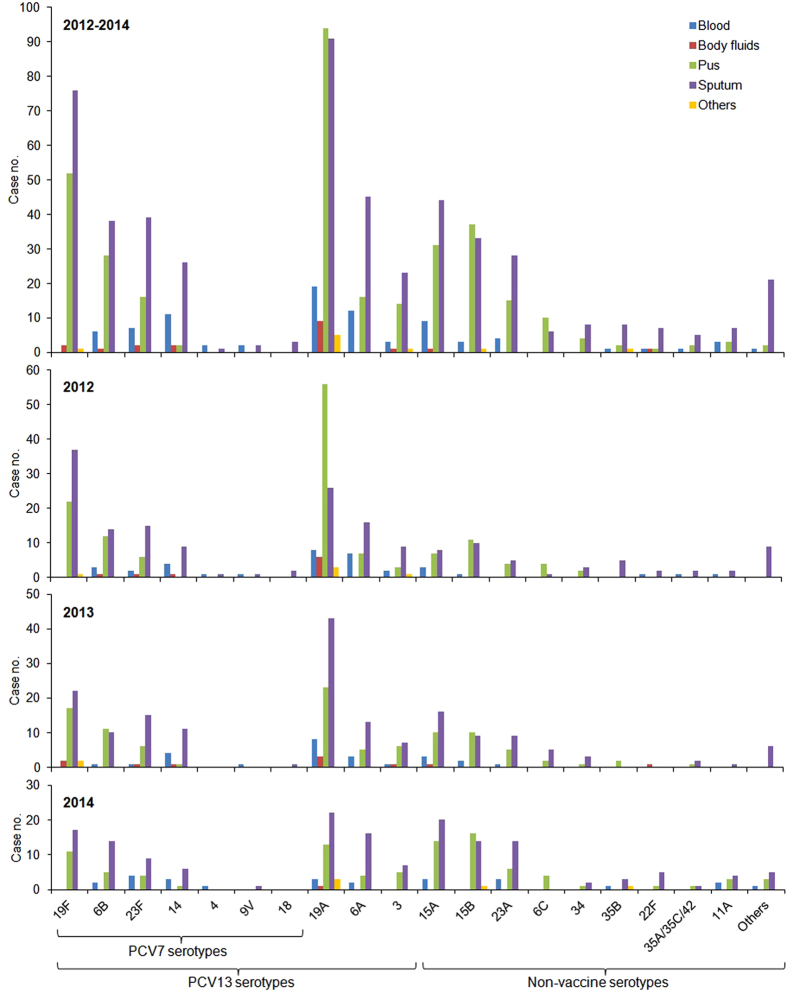
Site of infection-related serotype distribution among the 953 pneumococcal isolates studied during 2012–2014.[Other serotypes are 13, 20 (n = 4 each), 10A (n = 3), 8, 16F, 17F, 37 (n = 2 each), 7B/7C, 15F, 21, 22A, and 23B (n = 1 each)].